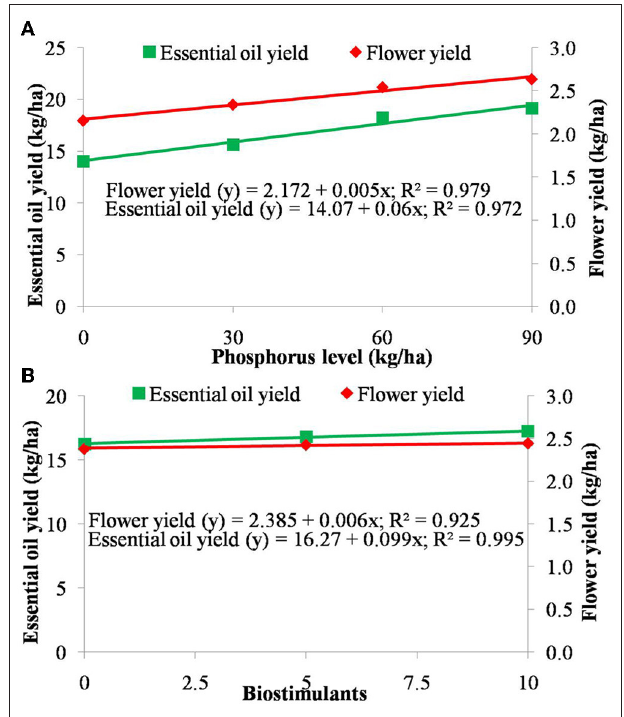
FIGURE 4 | Regression equation between independent variable, (A) levels of phosphorus (upper graph) and (B) biostimulant and dependent variables (lower graph) i.e., total flower yield (in kg ha − 1 ) and essential oil yield (in kg ha − 1 ). The levels of phosphorus and biostimulants are represented in the primary X axis. Total essential oil yield and flower yield are presented in the primary Y axis and secondary Y axis, respectively.